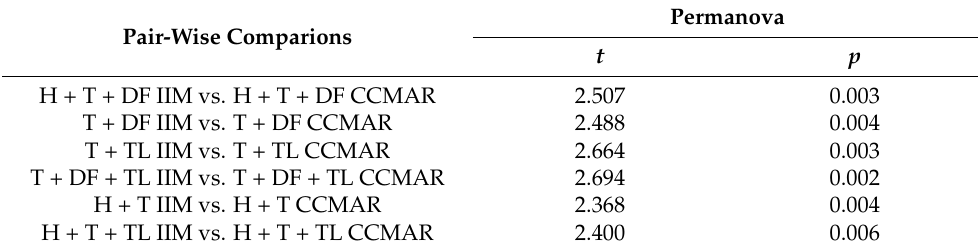
Table 4. Pair-wise comparisons of two-way crossed permutational multivariate analysis of variance (PERMANOVA) between the elemental fingerprints of the same body portions (seahorses missing one or two body parts mimicking damaged specimens) of long-snouted seahorses ( Hippocampus guttulatus ) from Instituto de Investigaciones Marinas (IIM) (Galicia, Spain) and Centro de Ci ê ncias do Mar (CCMAR) (Algarve, Portugal). H-head, T-trunk, DF-dorsal fin, and TL-tail ( n = 5). Pair-Wise Comparions